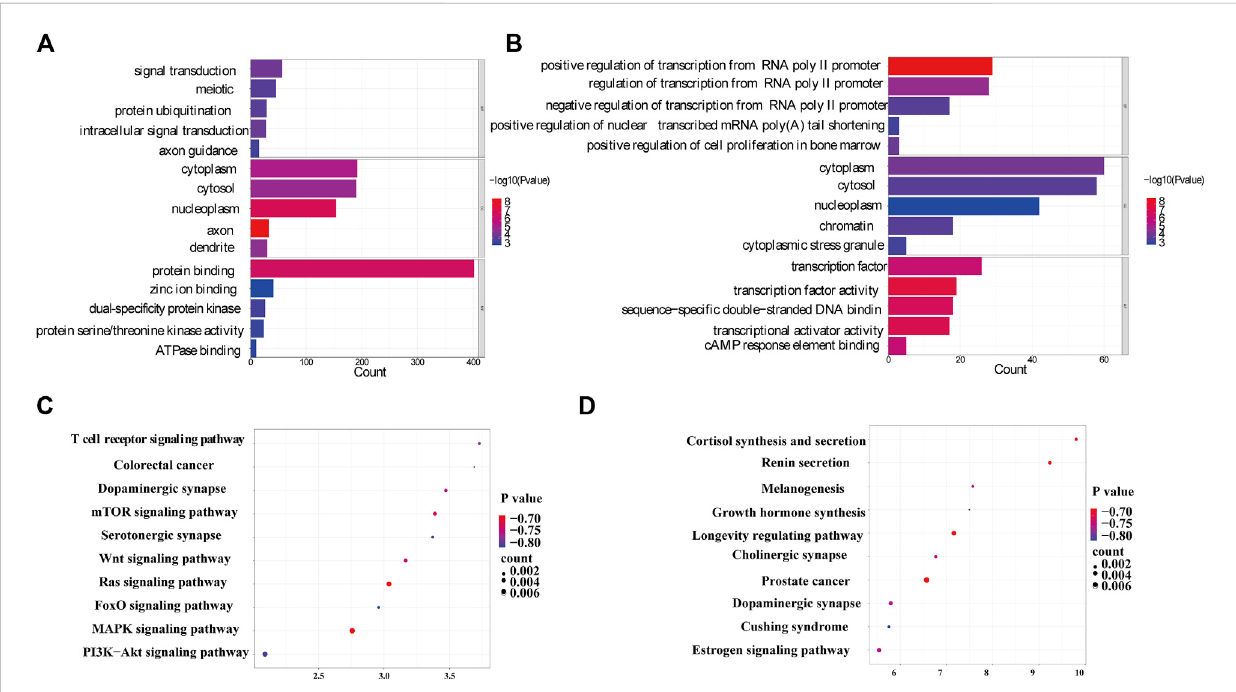
FIGURE 8 Gene function annotation of differential proteins. (A) The top fi ve annotations from GO terms for upregulated proteins. (B) The top fi ve annotations from GO terms for downregulated proteins. The color represents signi fi cant p values, with smaller p values resulting in a darker color. (C) The top ten pathways from KEGG for upregulated proteins. (D) The top ten pathways from KEGG for downregulated proteins. (GO, gene ontology; KEGG, kyoto encyclopedia of genes and genomes; BP, biological processes; MF, molecular function; CC, cellular